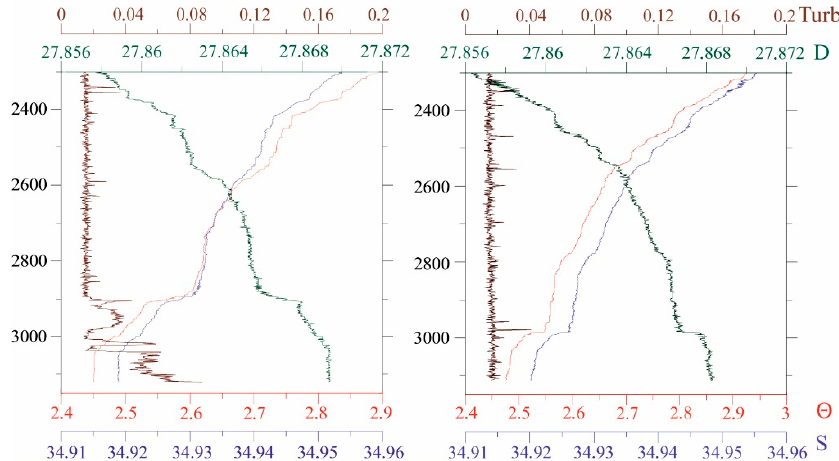
Figure 12. Changes in geophysical parameters near the Peterburgskoye HF: temperature (red, °C), salinity (blue, ‰), density (green, kg/m 3 ), turbidity (brown, FTU). On the ( left )—sounding immedi- ately after dredging; on the ( right )—sounding 12 days after dredging.